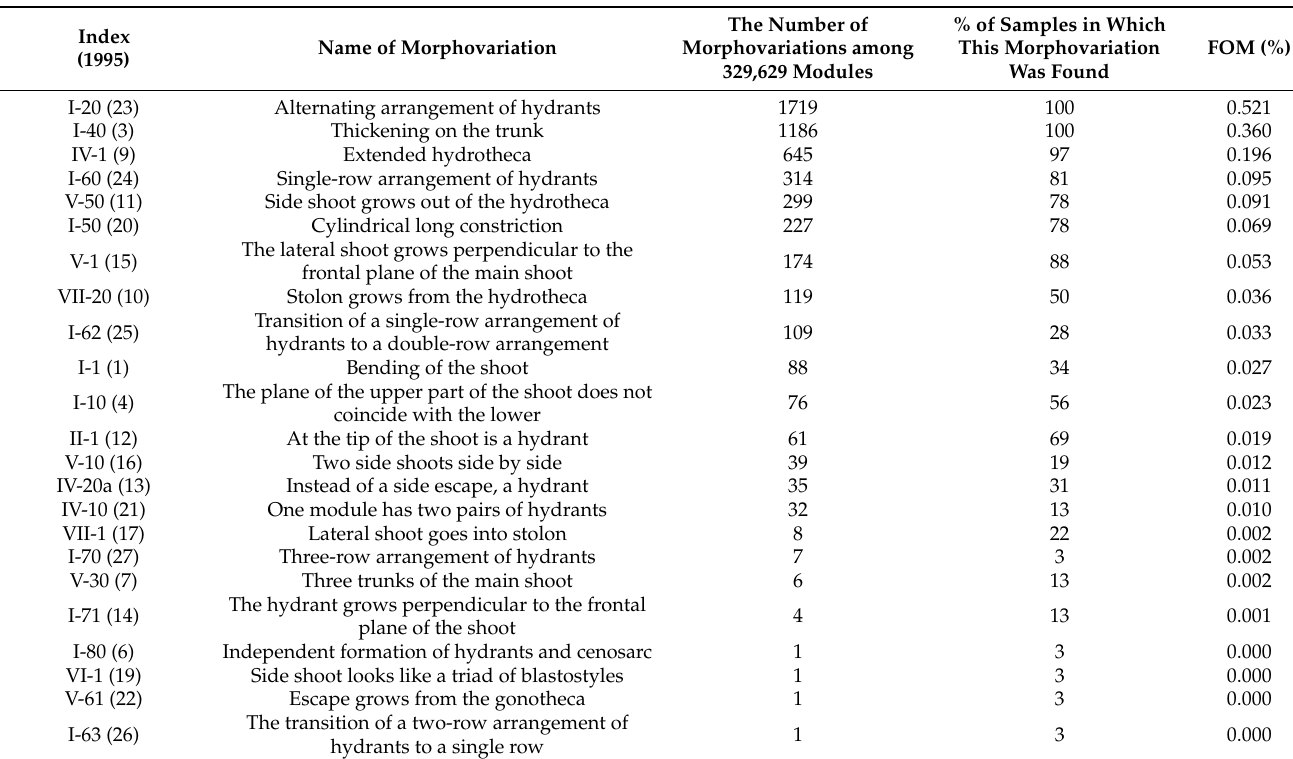
Table 1. The frequency of occurrence of the main morphovariation (FOM, %) in the shoot modules of the colonial hydroid Dynamena pumila (L., 1758), and the frequency of occurrence of each morphovariation (%) in 32 samples from the White and Barents Seas (1991–1994), including 329,629